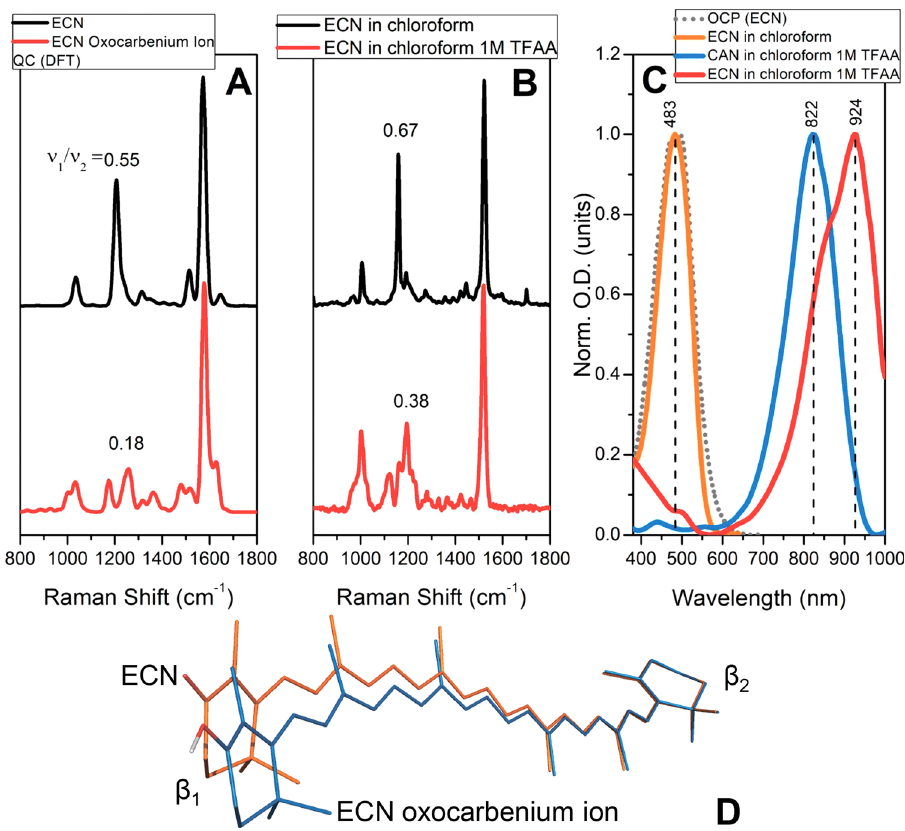
Fig. 5 Spectral signatures of protonated carotenoids. Vibrational properties of ECN (black) and the protonated ECN oxocarbenium ion (red), predicted by QC calculations ( A ) and con fi rmed by steady-state Raman spectroscopy ( B ). C Normalized steady-state absorption of ECN (red) and CAN (blue) oxocarbenium ions obtained by protonation of carotenoids using 1 M tri fl uoroacetic acid (TFAA) in chloroform. For comparison, the absorption of ECN in chloroform (orange) and of OCP in PBS solution (grey dotted line) are presented. D Equilibrium geometry of ECN (orange) and the corresponding oxocarbenium ion (blue) according to QC calculations. Structures were aligned at the β 2